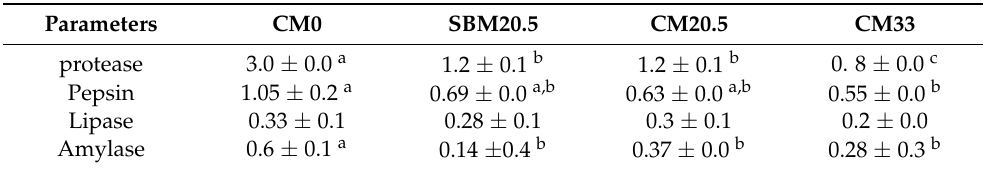
Table 7 represented the enzyme activity in the intestine of red seabream fed test diets. Intestinal enzyme activities (protease, lipase, and amylase) and stomach enzyme activity (Pepsin) in fish fed CM33 recorded the lowest values compared to the other group. Except for lipase, CM has an impact on enzyme activities in the intestine of red sea bream. Table 7. Enzyme activities (U/mg protein) in the intestine obtained after 60 days feeding period in red seabream fed diets formulated by replacing fish meal with camelina meal at 0% for reference diet (CM0), 20.5 g/kg with soybean mean (SBM20.5), 20.5 g/kg with camelina meal (CM20.5) and 33 g/kg camelina meal